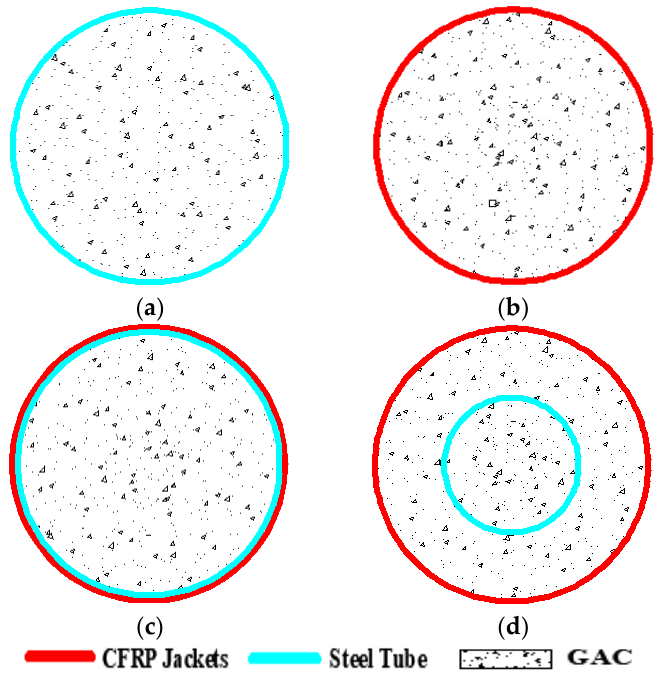
Figure 1. Different cross-section of composite columns: ( a ) CFST; ( b ) CFFT; ( c ) FCCFT; ( d ) DTCC.